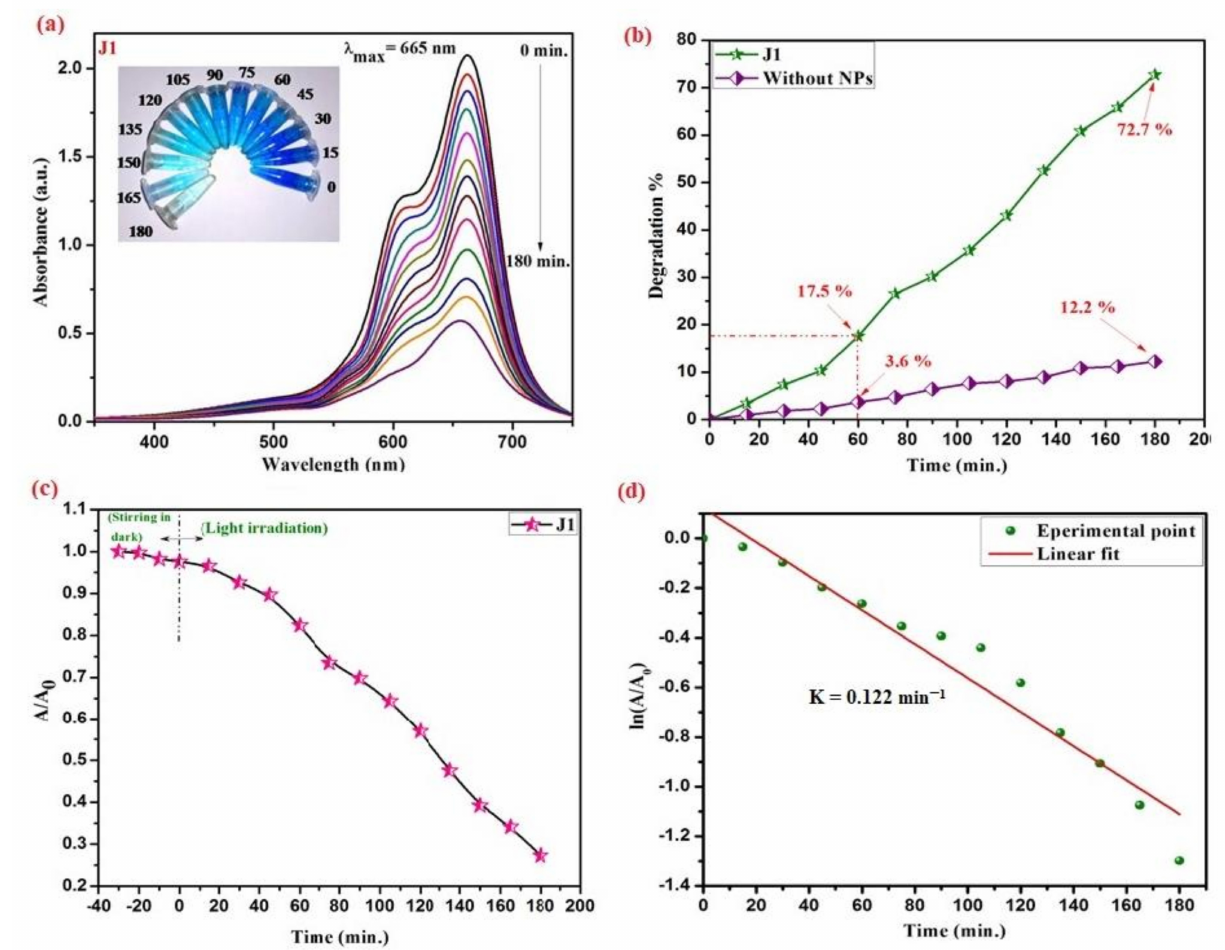
Figure 13. Photocatalytic dye degradation studies by ZnO-NPs ( a ) Absorption spectrum of MB dye samples along with decoloration of dye from dark blue to a nearly clear solution, as shown in the inset; ( b ) Time profile of degradation efficiency for MB dye ( c ) Normalized absorbance of dye in dark and sunlight in the presence of a catalyst ( d ) Kinetic study and rate constant calculated for the dye degradation